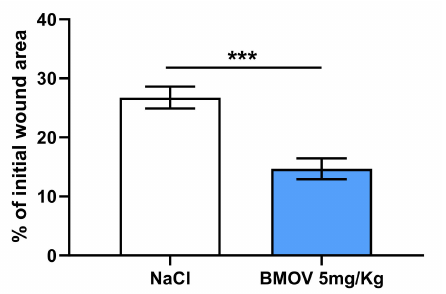
Figure 2. Quantification of in vivo wound area after 4 days’ treatment with either saline solution or 5mg / kg BMOV. Wound healing data from two independent experiments were pooled and expressed as estimated marginal means ± SEM. ***p < 0.001, n = 11-12 /